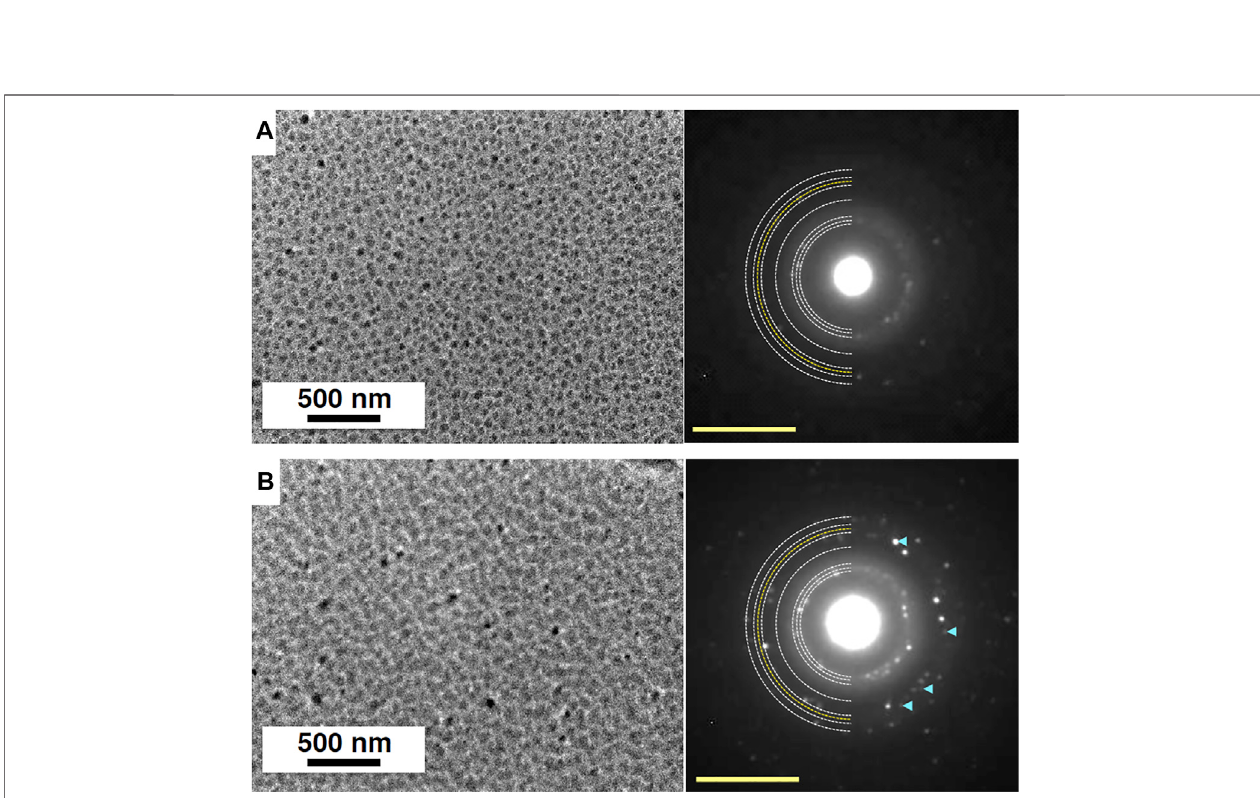
FIGURE6| TEMimagesandcorrespondingelectrondiffractionpatternsoficesamplesbeforeandafterUV-irradiation.Whiteandyellowsemicirculardottedlinesin electron diffraction patterns are powder diffraction patterns of ice Ih and 131 of ice XI, respectively. (A) Crystalline islands of ice Ih deposited at 150 K and observed at 75 K. The electron diffraction pattern can be indexed as diffraction of ice Ih. (B) Ice sample exposed to UV dose of ∼ 4 × 10 16 photons cm − 2 at 75 K. The appearance of additional diffraction spots shown by pale blue arrowheads can be indexed as the 131 diffractions of ice XI. Yellow scale bars, 5 nm − 1 .